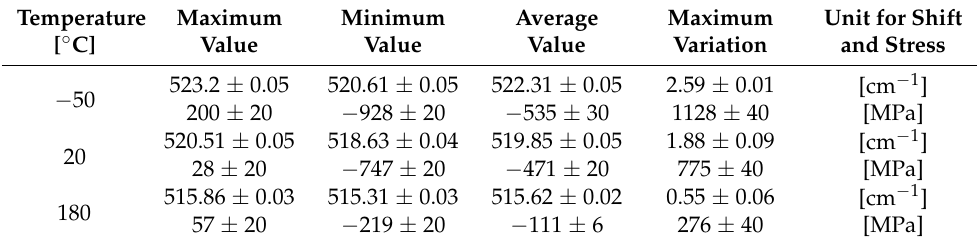
Table 6. Raman shift [cm − 1 ] and stress values [MPa] obtained for the A_AuSn sample.